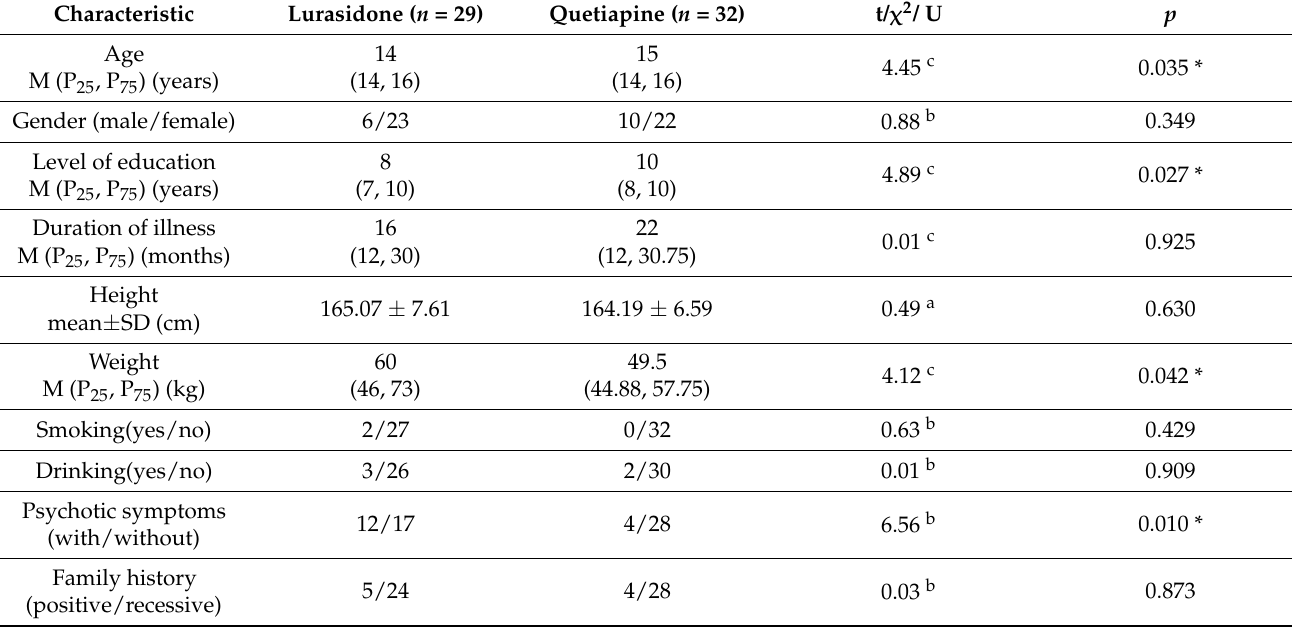
Table 1. Demographic and clinical characteristics at baseline.